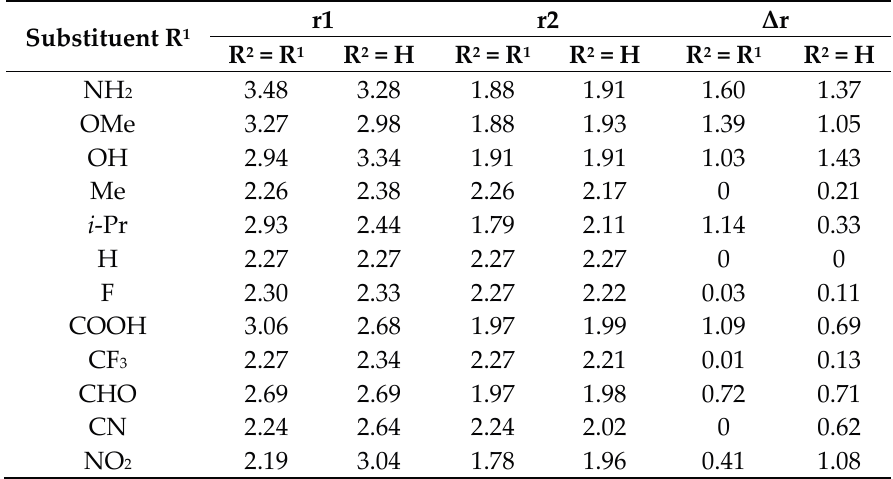
Figure 4. Transition state structures for the reaction of butadiene with: ( a ) fragment 1 substituted with two NH 2 groups; ( b ) fragment 1 substituted with one NH 2 group; ( c ) fragment 2 substituted with two NH 2 groups; ( d ) fragment 2 substituted with one NH 2 group; ( e ) fragment 1 substituted with two NO 2 groups; ( f ) fragment 1 substituted with one NO 2 group; ( g ) fragment 2 substituted with two NO 2 groups; ( h ) fragment 2 substituted with one NO 2 group. Table 4. Distances r1 and r2, in Å, for the transition states of reactions of fragment 2 shown in Figure S6. Also Δ r = r1 −